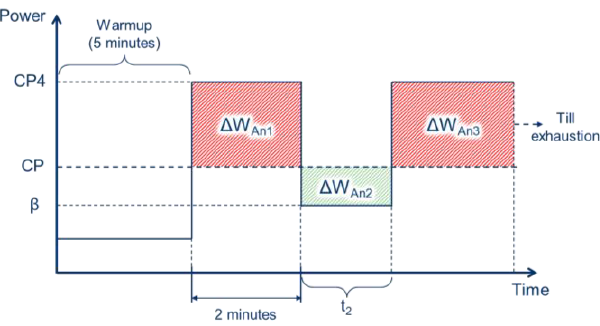
Figure 1. Visual Representation of Experimental Protocol.